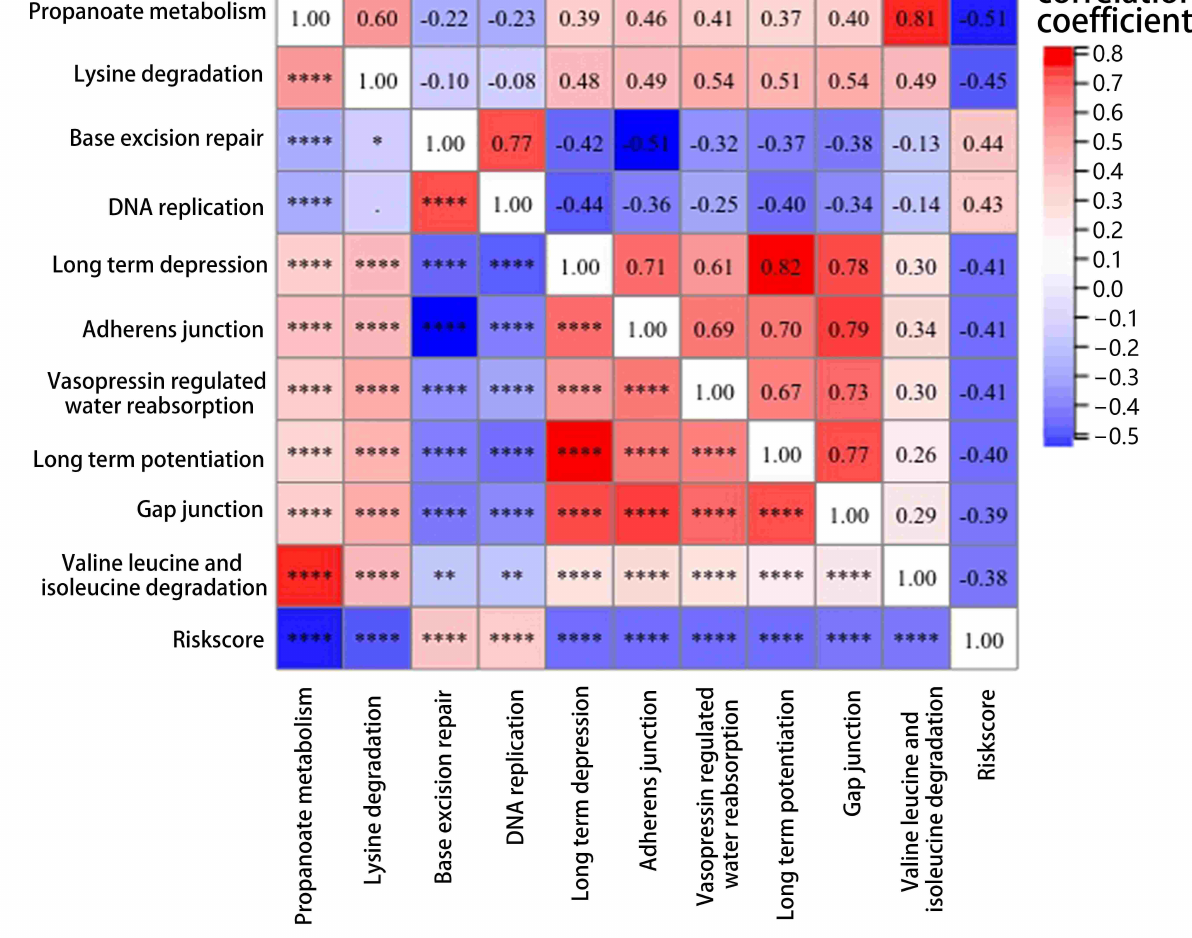
FIGURE 6. The correlation between risk score and KEGG pathways. * p < 0.05, ** p < 0.01, *** p < 0.001, **** p <